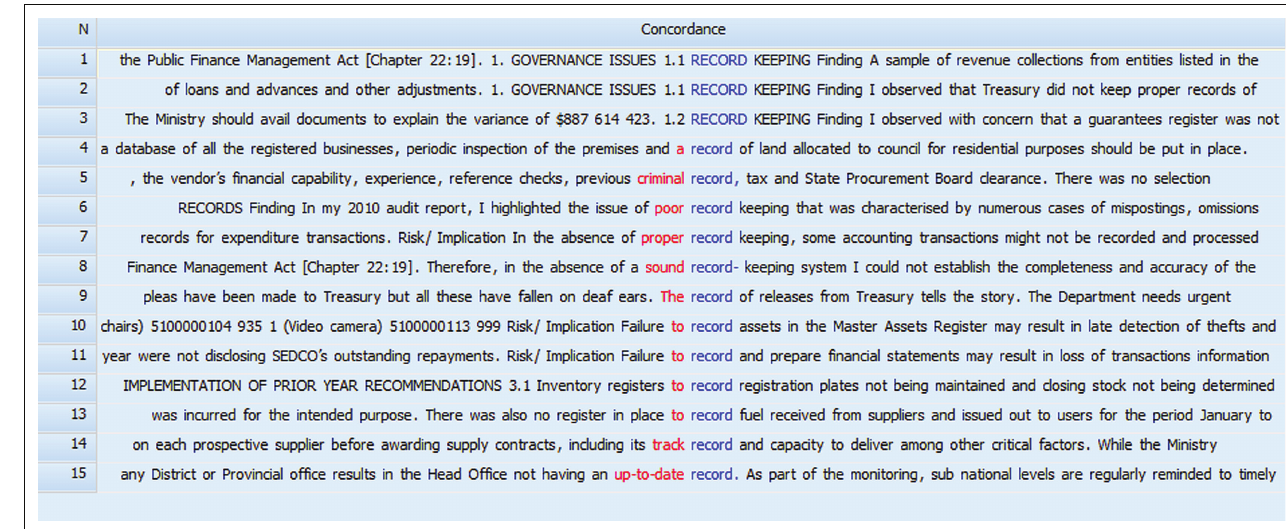
FIGURE 4: The Comptroller and Auditor General of Zimbabwe Statements of Audited Financial Accounts for the year ended 31 December 2011 for government ministries.